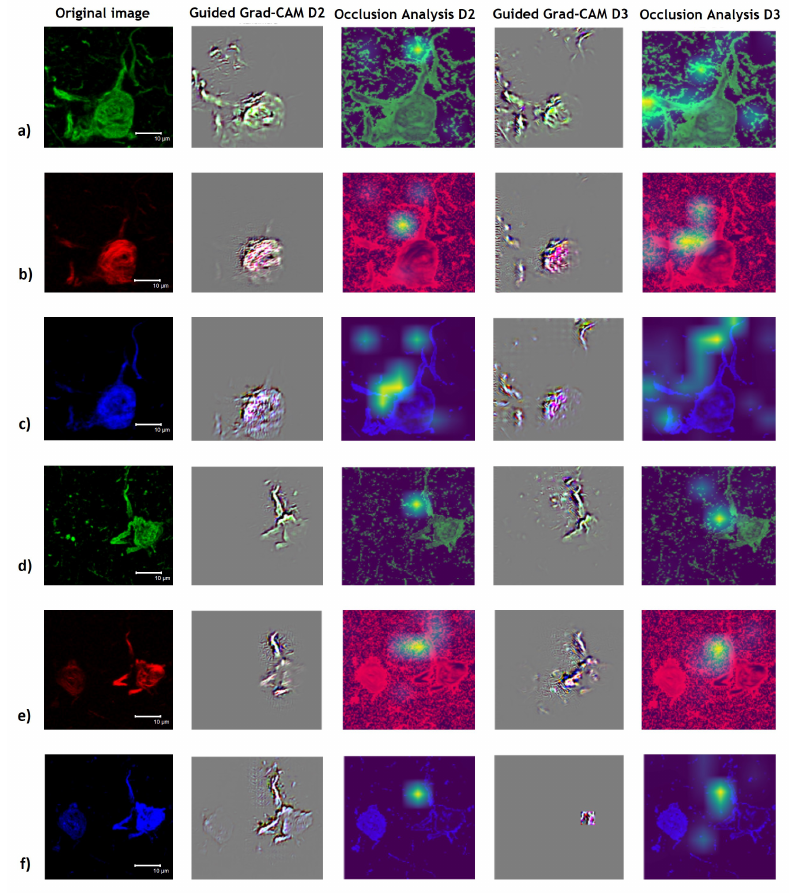
Figure 12. Model interpretability studies using XAI techniques for PSP and AD classification in the entorhinal cortex region of patients with tauopathies. ( a – c ) Guided Grad-CAM analysis (second and fourth column) for AD classification highlights the most prominent NFT of the image; however, for D2 mostly the entire NFT is spotted and for D3 the southwest region of the tangle is spotted. The Occlusion Analysis (third and fifth column) highlights the northern and center region (for D2 and D3) of the image. ( d – f ) Guided Grad-CAM analysis (second and fourth column) for PSP classification mainly highlights all the originally most prominent immunoreactive middle portion of the image (for D2 and D3). Occlusion Analysis (third and fifth column) highlights the center of the image near the apex of the central NFT (for D2 and D3). In the green channel ( a , d ), immunoreactivity of the AT8 antibody directed against the biomarker for dual phosphorylation at serine 202 and threonine 305 of the Tau polypeptide is observed ( a , d ). The red channel ( b , e ) shows staining with Thiazine red dye for fibrillar forms of pathological Tau aggregates. The blue channel ( c , f ) shows immunoreactivity of the pS396 antibody directed against the biomarker for phosphorylation at amino acid serine 396 of Tau